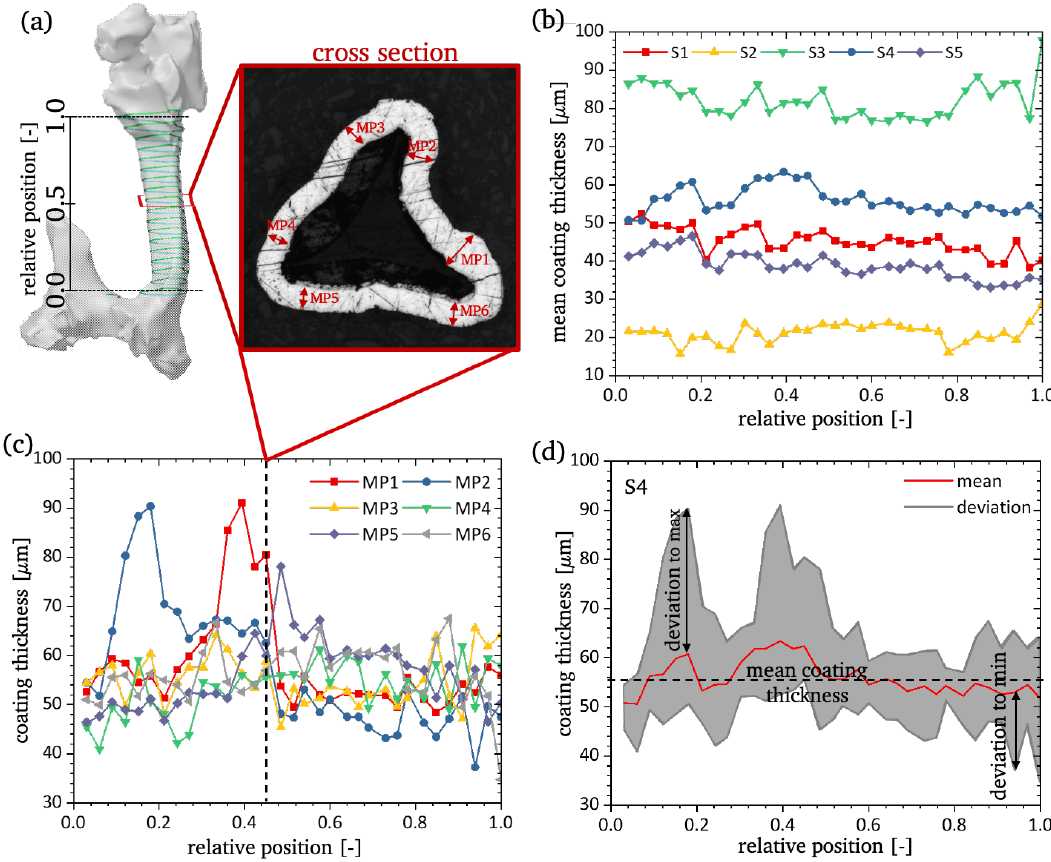
Figure 5. ( a ) Scheme of micro-sections for strut S4; ( b ) mean coating thickness for all five struts (S1–S5); ( c ) coating thickness at six measuring points (MP1–MP6) for one strut (S4); ( d ) mean coating thickness and scatter band for one strut (S4) with marked position of maximum and minimum